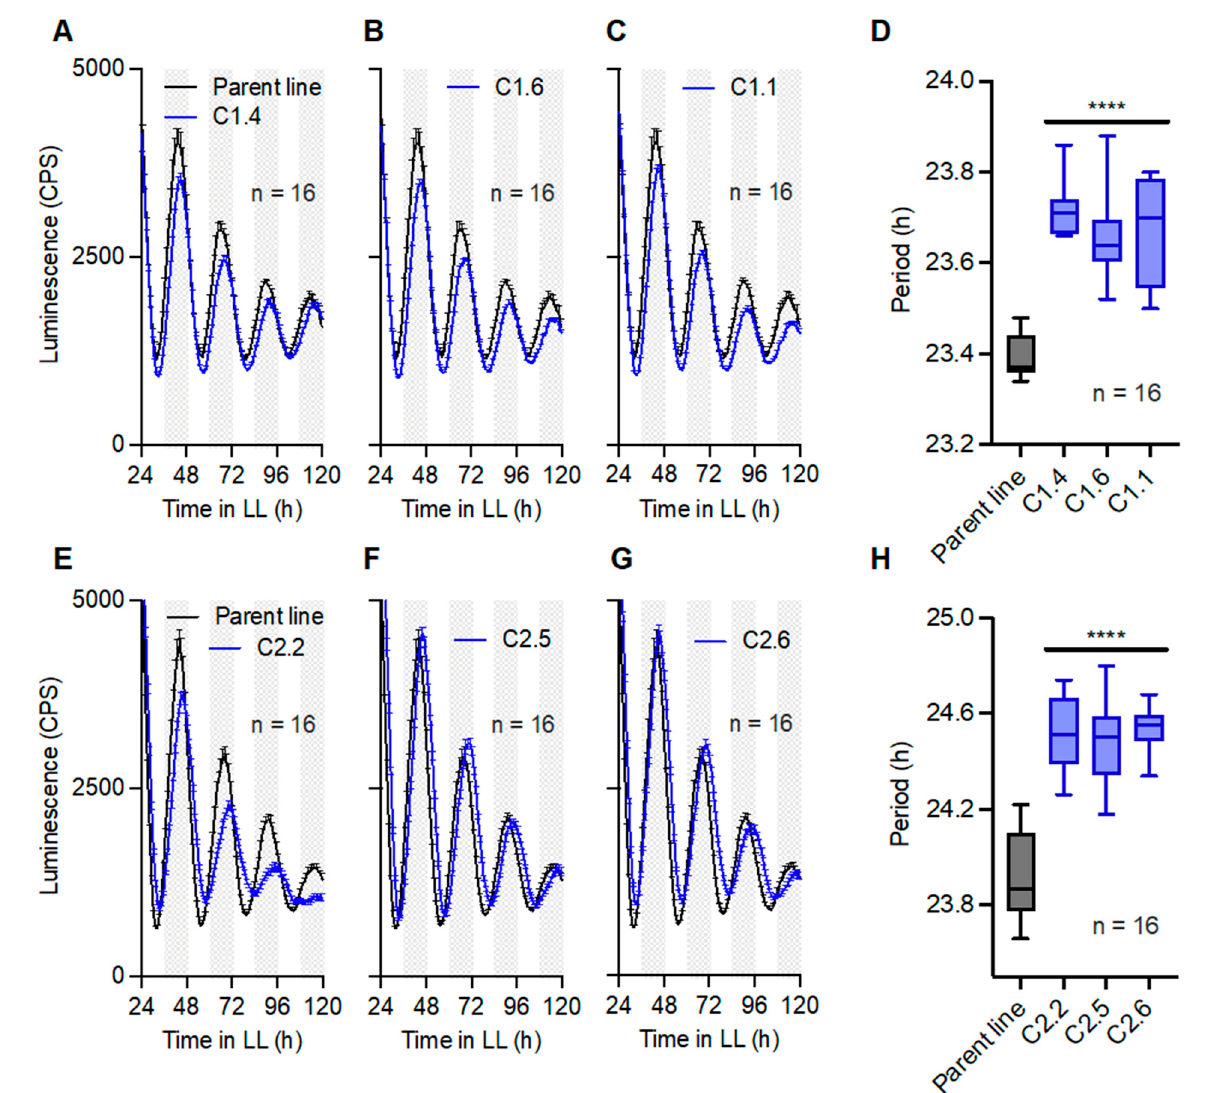
Figure 3. CNNM proteins affect circadian clock gene expression rhythms. Luminescent CCA1-LUC rhythms and period analyses under LL for lines overexpressing CNNM1 ( A – D ) and CNNM2 ( E – H ). Luminescent data are represented as mean ± SEM. Period data are shown as boxplots, where middle lines indicate the median, lower and upper boundaries represent the 25th and 75th percentiles, respectively, and error bars show data distribution from lowest to highest value. n = technical replicate number. Grey areas represent subjective night periods. **** = p < 0.0001; statistical analyses are compared with the parent line; Student’s t-test. CPS = Counts per second, h = hours.